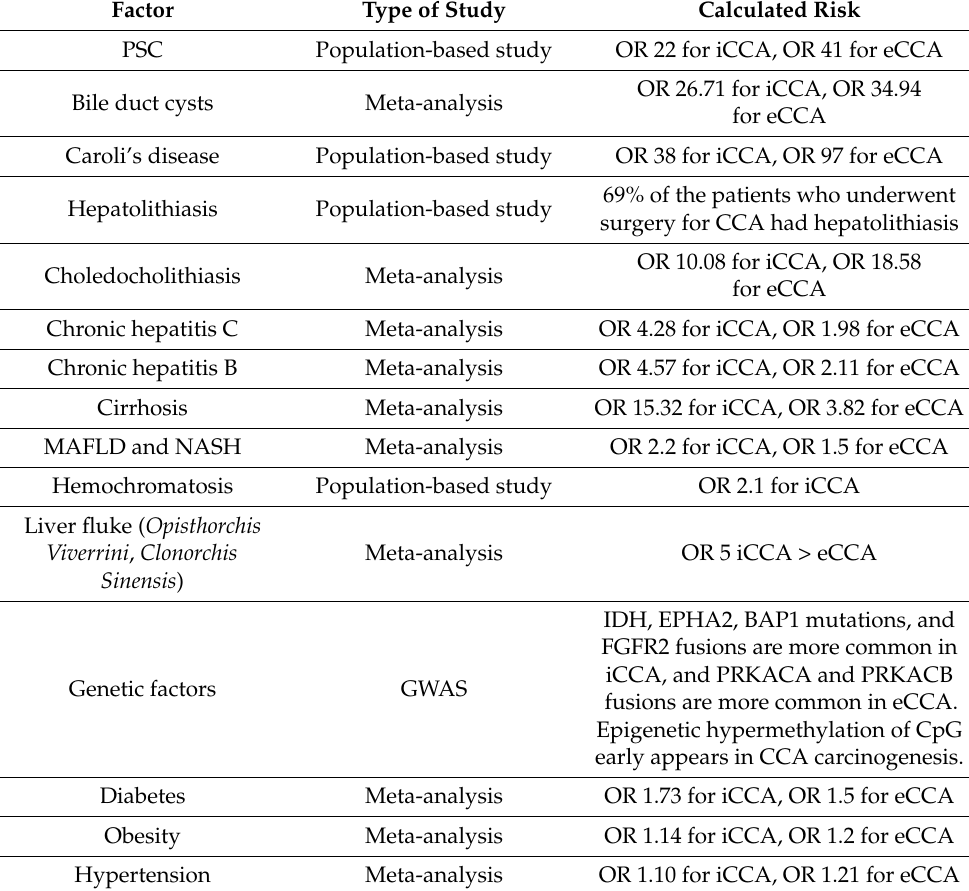
Table 1. Risk factors for CCA. Established, emerging, and controversial risk factors for CCA. Factor Type of